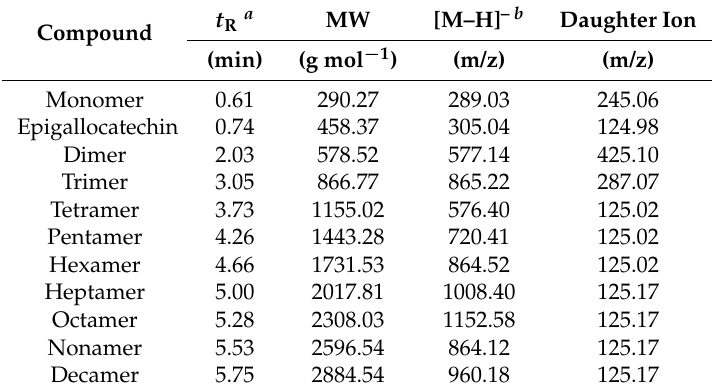
Table 2. Tandem MS/MS settings for multi-reaction monitoring (MRM) detection of monomeric- decameric